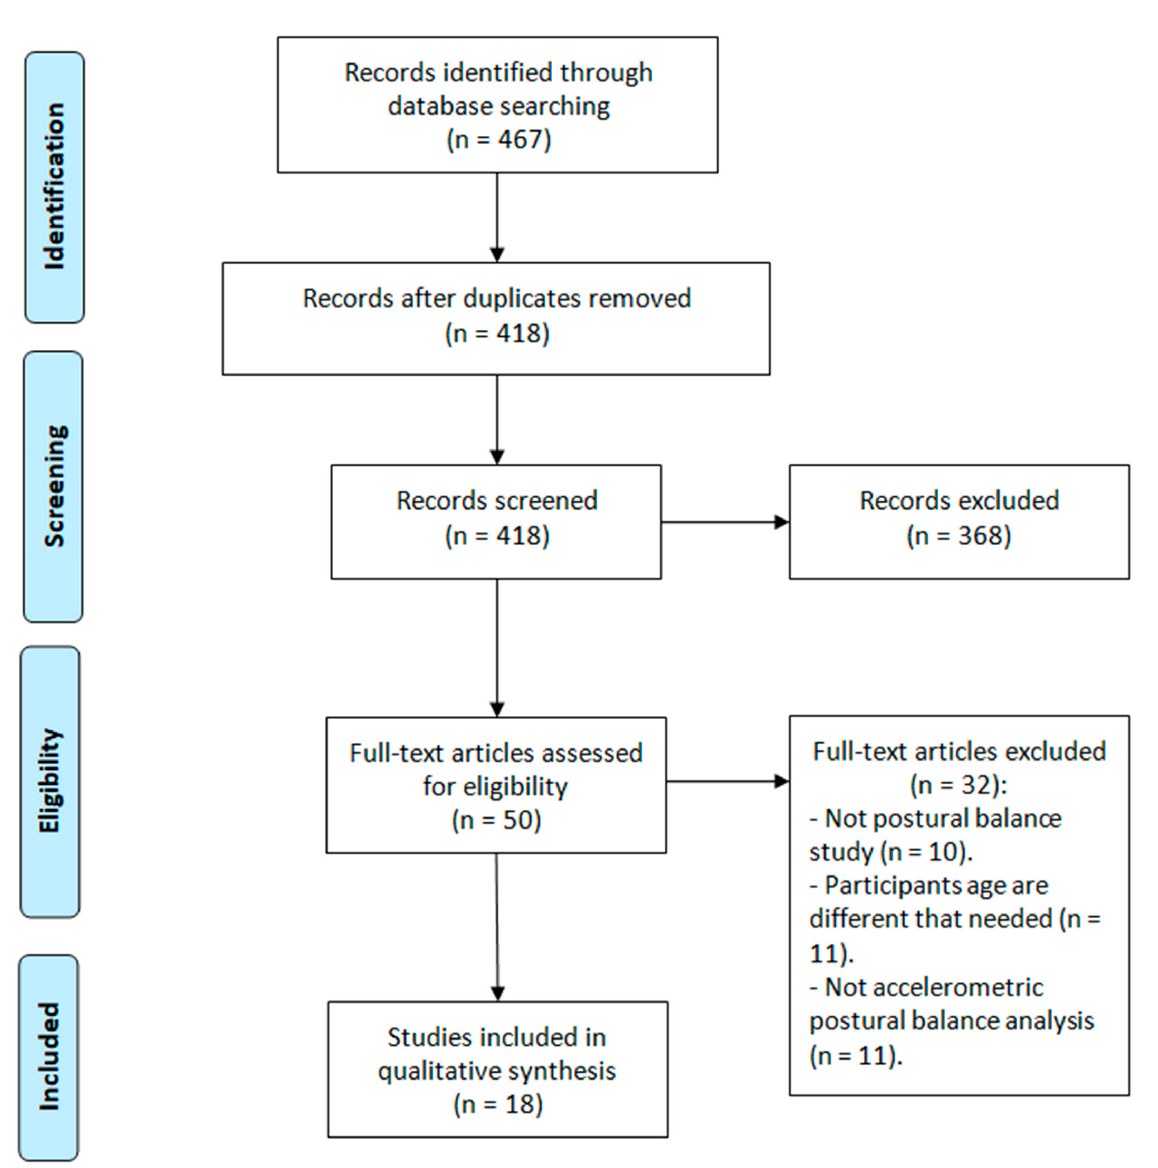
Figure 1. Preferred Reporting Items for Systematic Reviews and Meta-analyses (PRISMA) flow diagram.